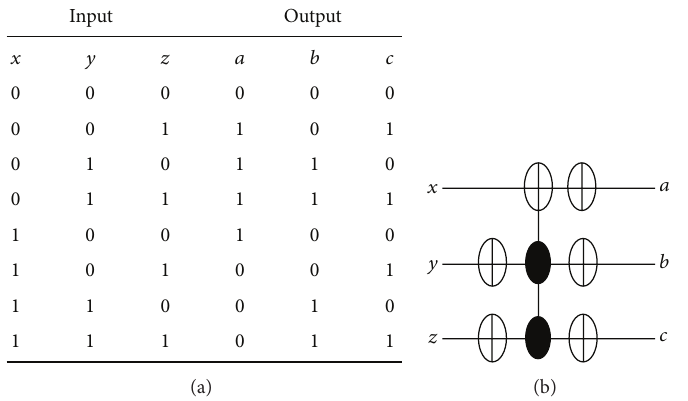
Figure 14: A reversible circuit with single Toffoli gate and five NOT gates: (a) truth table, (b) reversible circuit representation.